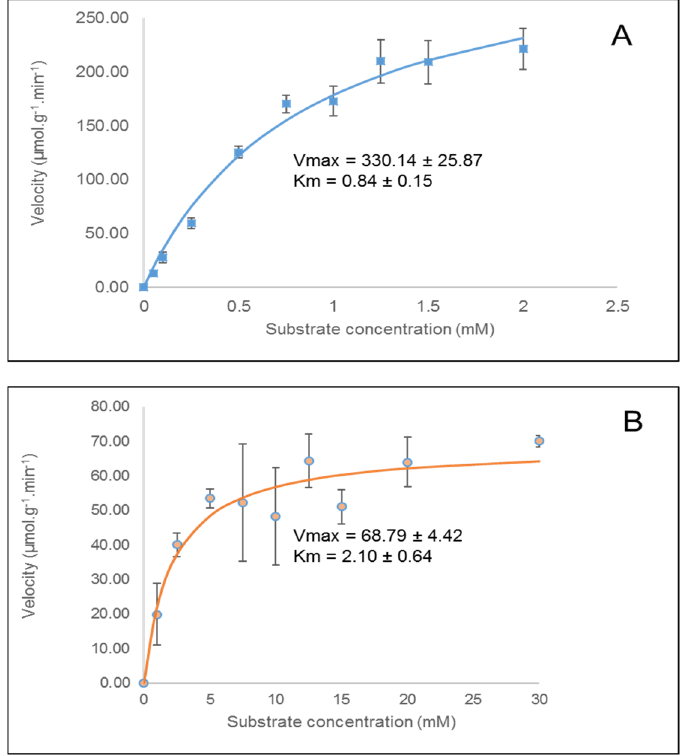
Figure 4. Kinetic constants K m and V max for acetylcholinesterase ( A ) and butyrylcholinesterase ( B ) with acetylthiocholine iodide as substrate.